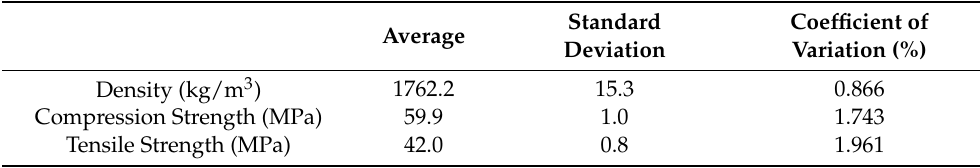
Figure 3. Mix proportion of polyurethane concrete (the proportion of quality in total quality). Table 5. Mechanical and physical properties of polyurethane concrete.